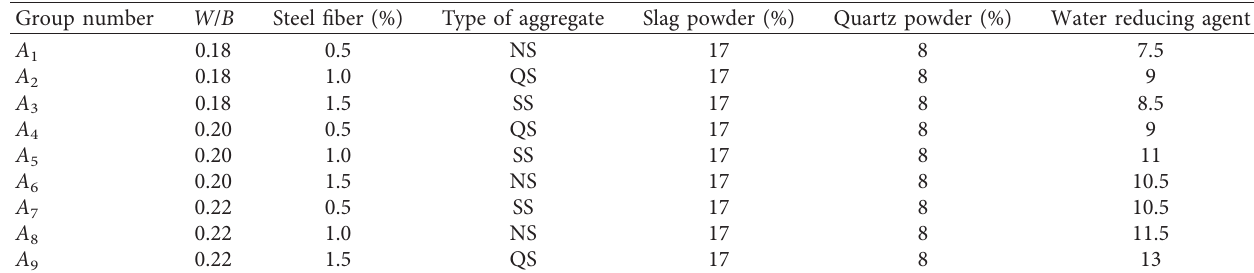
Table 4: Steel fiber UHPC mix proportion (kg/m 3 ).